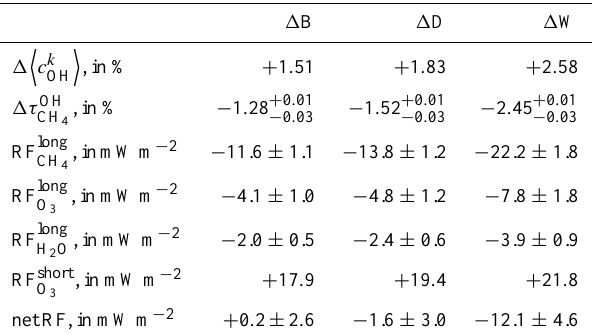
Table 4. Changes in methane concentration and lifetime, as well as radiative forcing for 0.847Tg aviation N per year in an atmosphere without Reaction (R2) ( 1 B), with (R2a) ( 1 D), and (R2b) ( 1 W). The other RF short values are based on the stratospheric adjusted O 3 RF diagnostic of Dietm¨uller (2011), i.e. Eq. (11). All other long- lived forcing terms reflect the steady state response of the atmo- sphere to sustained aircraft NO x emissions of the year 2000, based on methane lifetime changes due to [OH] perturbations. RF long and RF long are calculated according to Ramaswamy et al. (2001), O 3 RF long according to Myhre et al. (2007): Eqs. (11), (16), (17) and H 2 O (18). All results refer to the global domain with an upper boundary at 50hPa. Uncertainties are discussed in Sect. 5, including those terms without explicitly given error